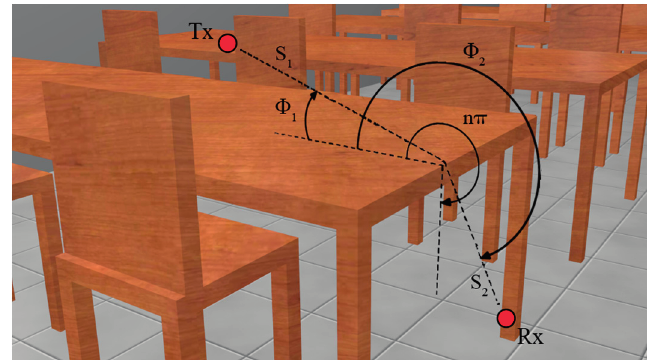
Figure 3. Geometry for wedge diffraction coefficients.